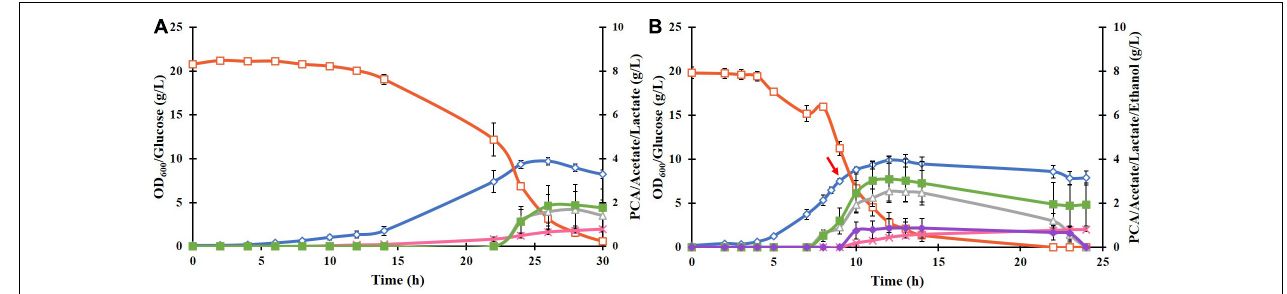
FIGURE 2 | (A) Culture parameters of E. coli BL21(DE3)-DSD during an aerobic batch cultivation in a bioreactor in modified M9 medium at constant temperature of 37 ◦ C, pH 7 and stirring rate of 600 rpm. Expression of DSD gene was done by addition of 0.1 mM IPTG at: (A) 0 h, and (B) at 9 h after the start of the cultivation shown by a red arrow. The cultivations were performed in duplicates. The symbols denote profiles of cell density measured as OD 600 ( ♦ ), concentrations of glucose ( (cid:3) ), PCA (x), acetate ( (cid:52) ), lactate ( (cid:4) ), and ethanol ( (cid:7)